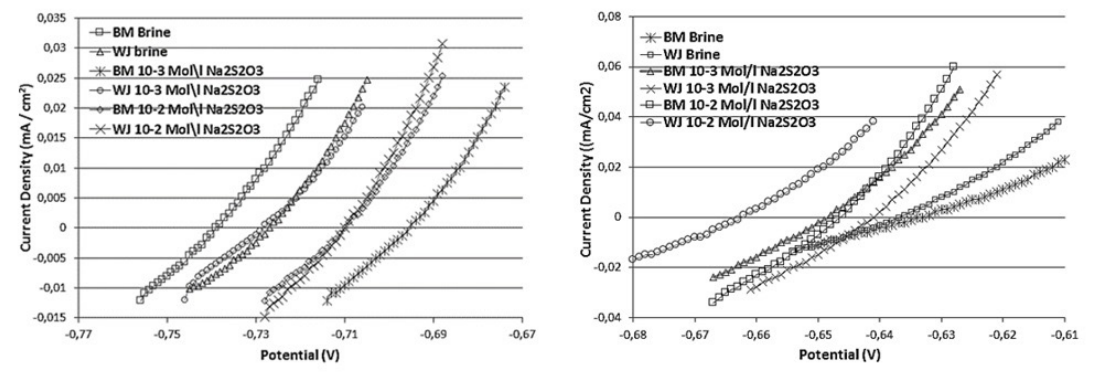
Figure 13. Characteristic LPR Curves of BM and WJ in different environments with: a) pH=5.0 and b) pH=3.0, respectively.